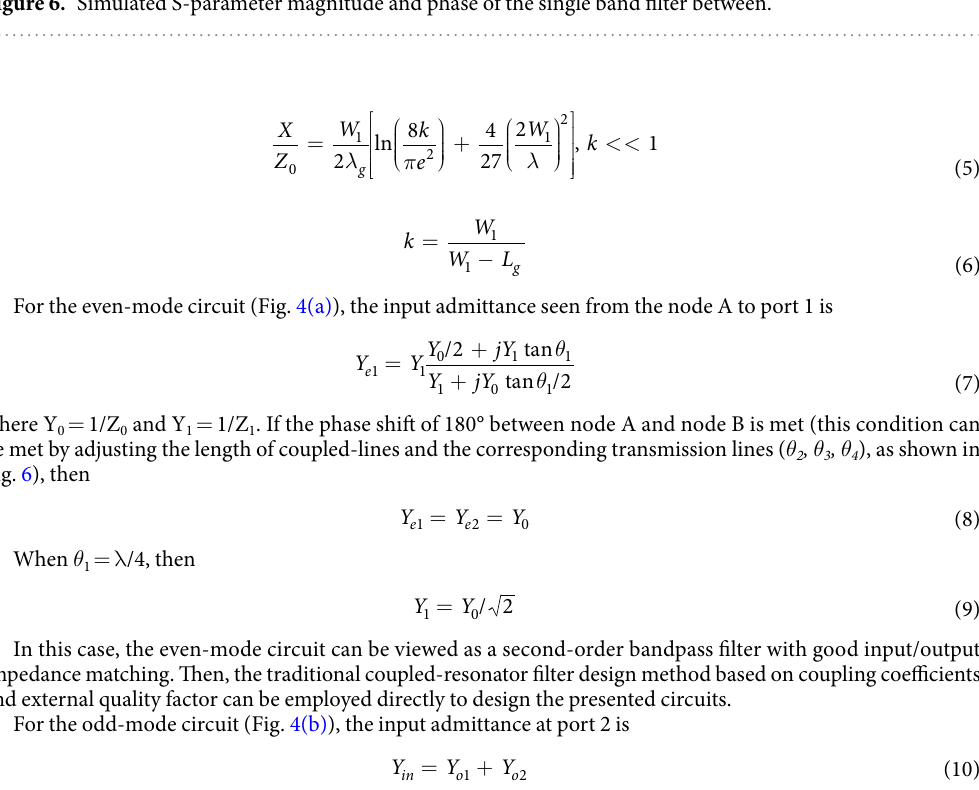
Figure 6. Simulated S-parameter magnitude and phase of the single band filter